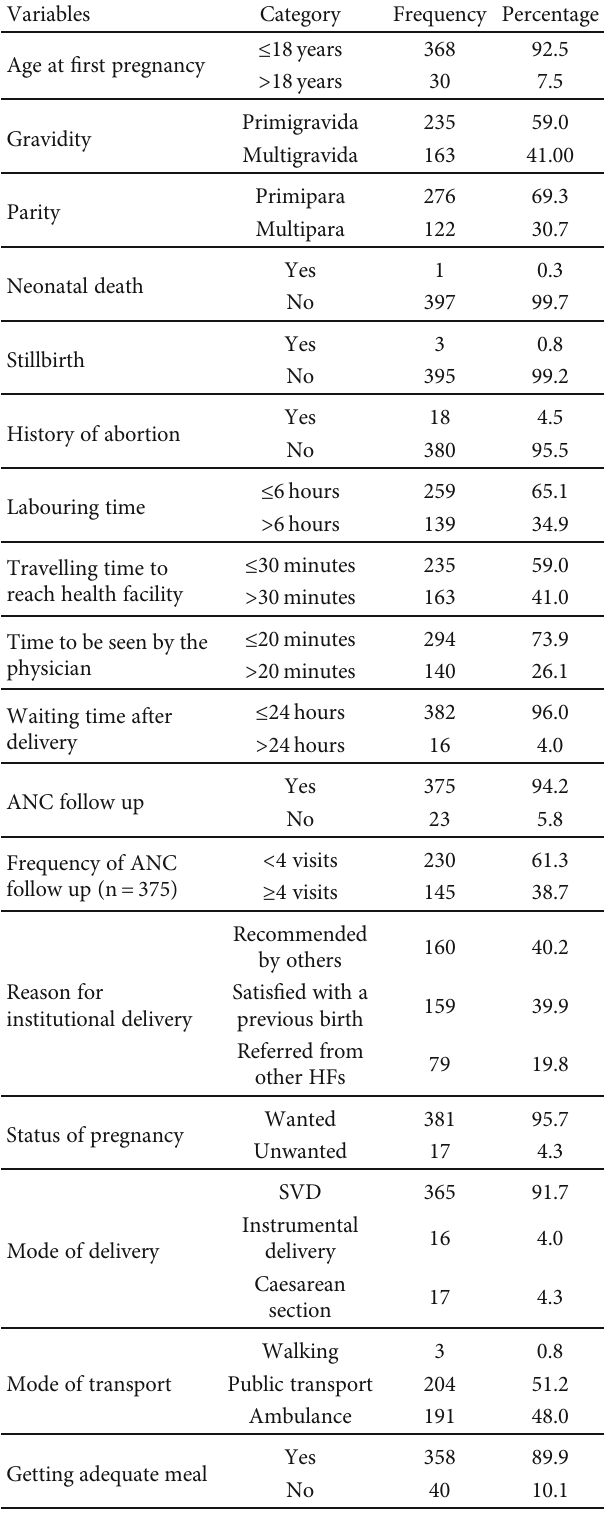
Table 1: Sociodemographic characteristics of mothers who gave birth in public hospitals of North Wollo Zone, Northeastern Ethiopia, 2019 ( N = 398 ).